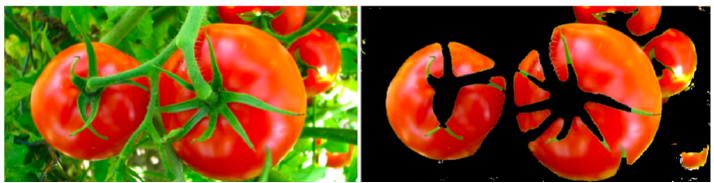
Figure 13. Post-processing output ( left ) and final processed image ( right ) with errors marked in blue.